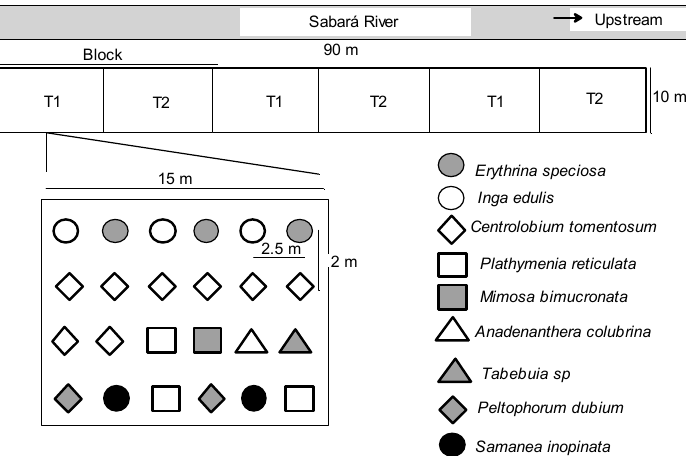
Figure 2. Model of riparian restoration in Sabará River, Brazil. References: T1, treatment: block fertilized with organic matter (OM); T2, treatment: block fertilized with natural rock phosphate (P); each treatment block has 15 × 10 m area; each treatment has three replications ( n = 3).